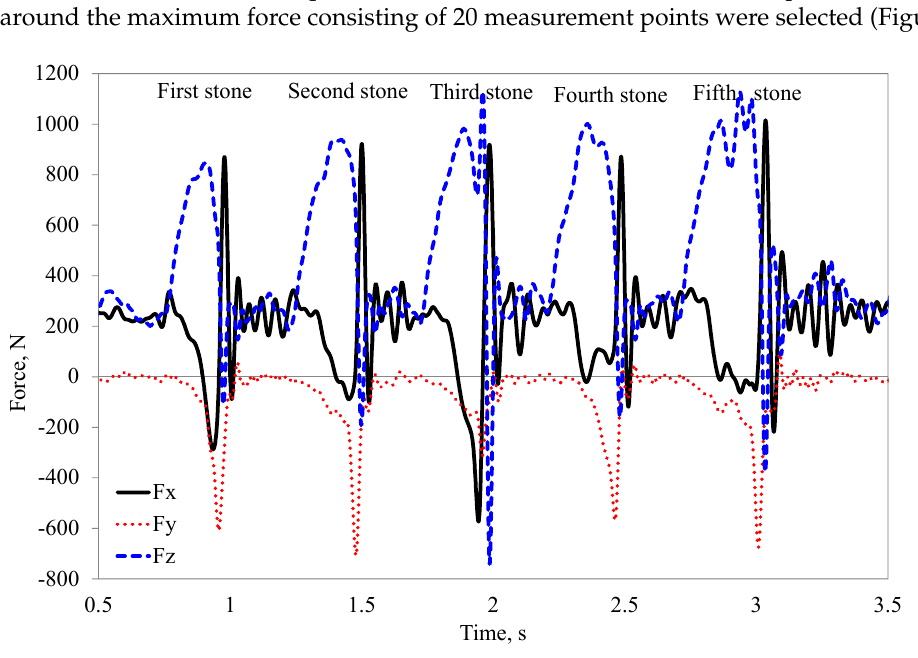
Figure 8. An example of recorded forces F x , F y and F z in three mutually perpendicular directions during the operation of the flexible tine with the duckfoot tool at the depth of 0.07 m and a speed of 1.67 m·s –1 (repeated peaks indicate force dynamics before and after contact with the stone).